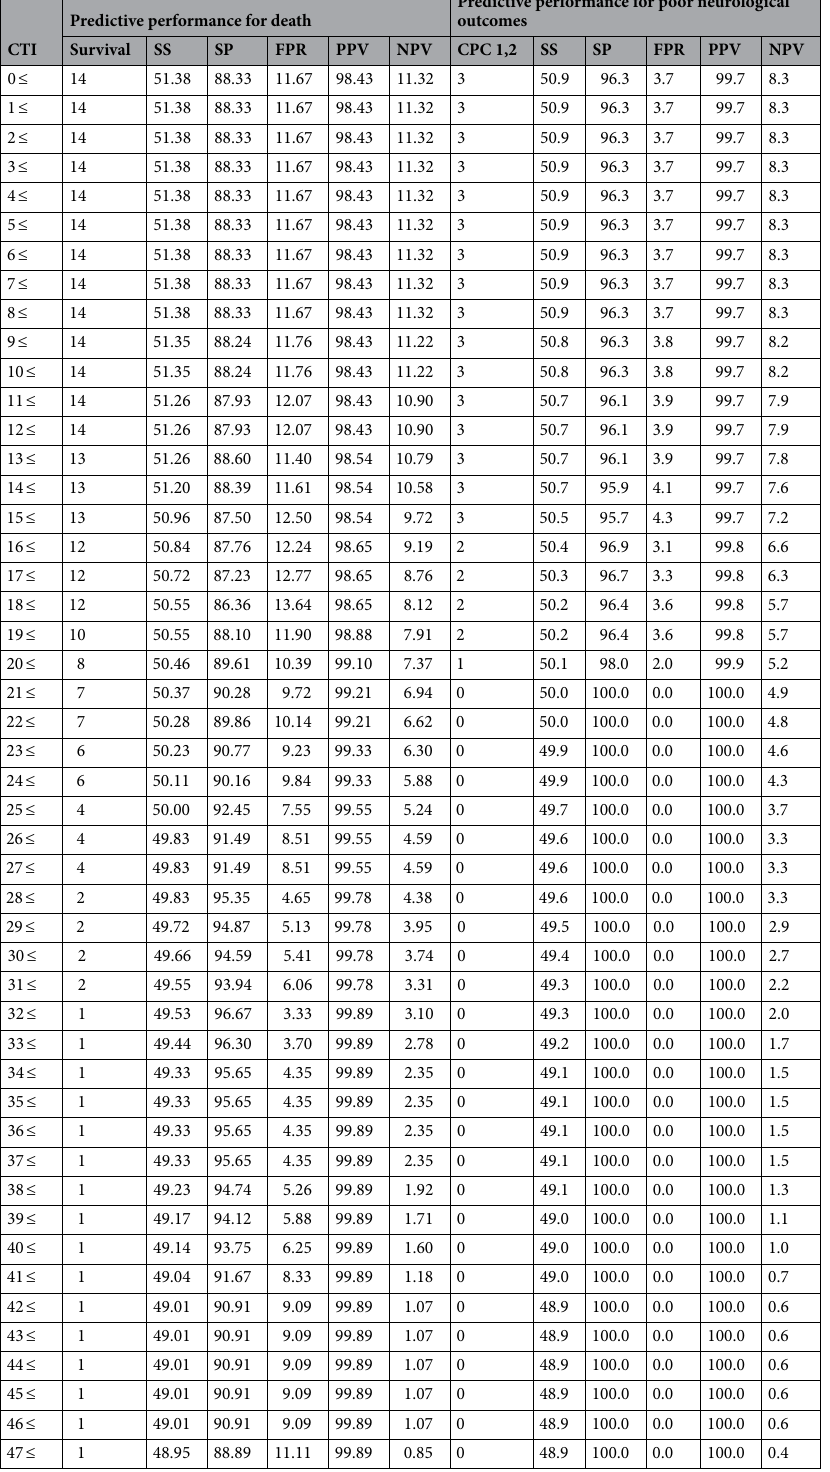
Table 3. The cutoff compression time interval in the group met the BLS TOR rule and its predictive performance for death and poor neurological outcomes at hospital discharge. Variables are presented as numbers and percentages (%). The survival number and CPC 1 and 2 indicate patients who met the BLS TOR rule but survived and showed good neurological outcomes. BLS, basic life support; TOR, termination of resuscitation; CTI, compression time interval; SS, sensitivity; SP, specificity; FPR, false-positive rate; PPV, positive predictive value; NPV, negative predictive